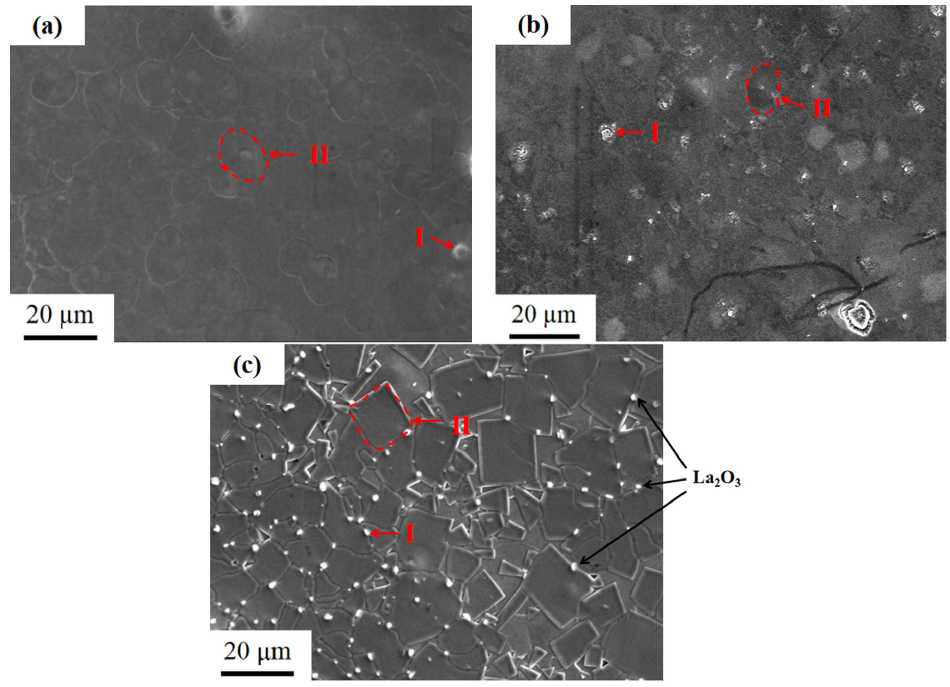
Figure 4. SEM images of LaFe 11.5 Si 1.5 C 0.2 ribbons annealed at 1273 K for different times: ( a ) 0 min; ( b ) ( b ) 3 min; ( c ) 2 3 min; ( c ) 2 h. Table 4. Inside grains and white grains the EDS analysis of LaFe 11.5 Si 1.5 C 0.2 ribbons at a wheel speed of 35 m/s annealed at 1273 K for different times. Heat Treatment Time